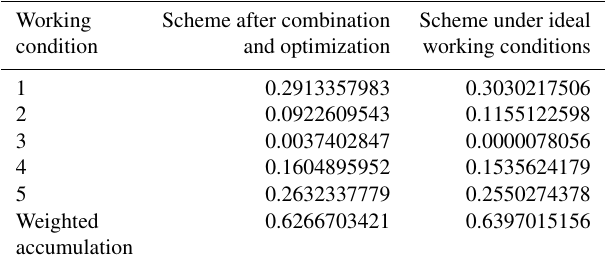
Table 2. Maximum deviations of the two schemes under the afore- mentioned working